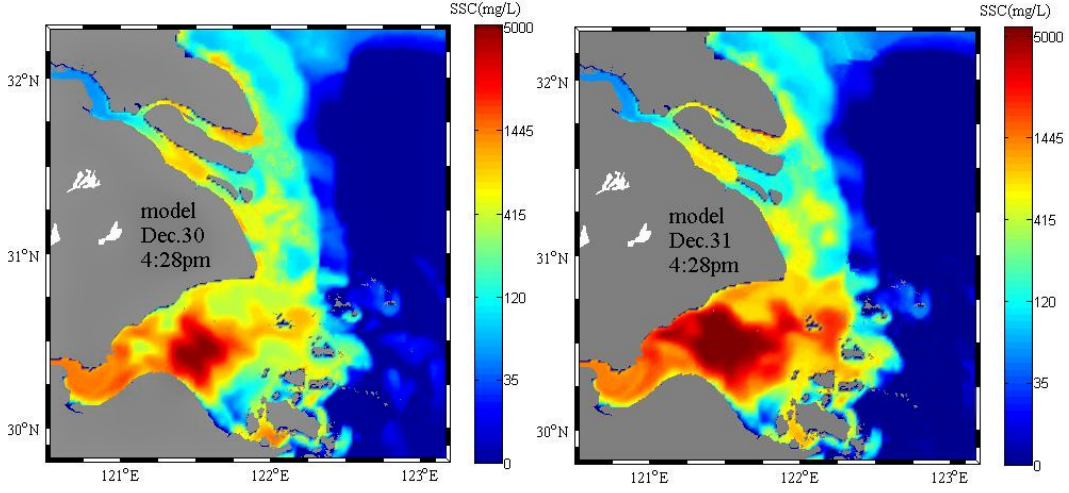
Figure 4. Modeled surface SSC (mg/L) in the study area at 4:28 p.m. on 30 and 31 December 2013.